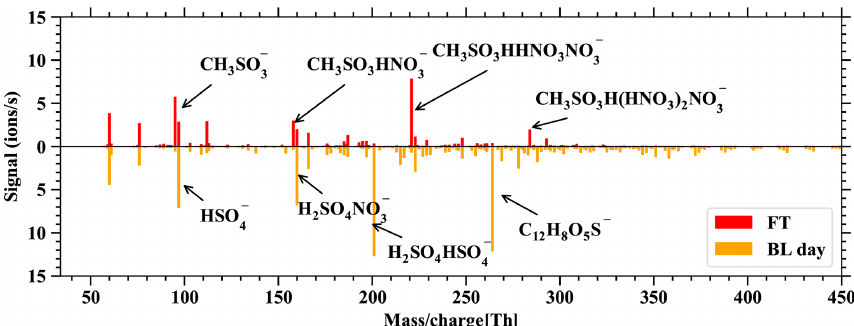
Figure D3. Spectra of the nitrate-CIMS, showing the difference between FT – BL day on the positive axis and BL day – FT on the negative axis. Only very few compounds are larger in FT than BL day : the positive spectrum is dominated by clusters of the primary ions with MSA.